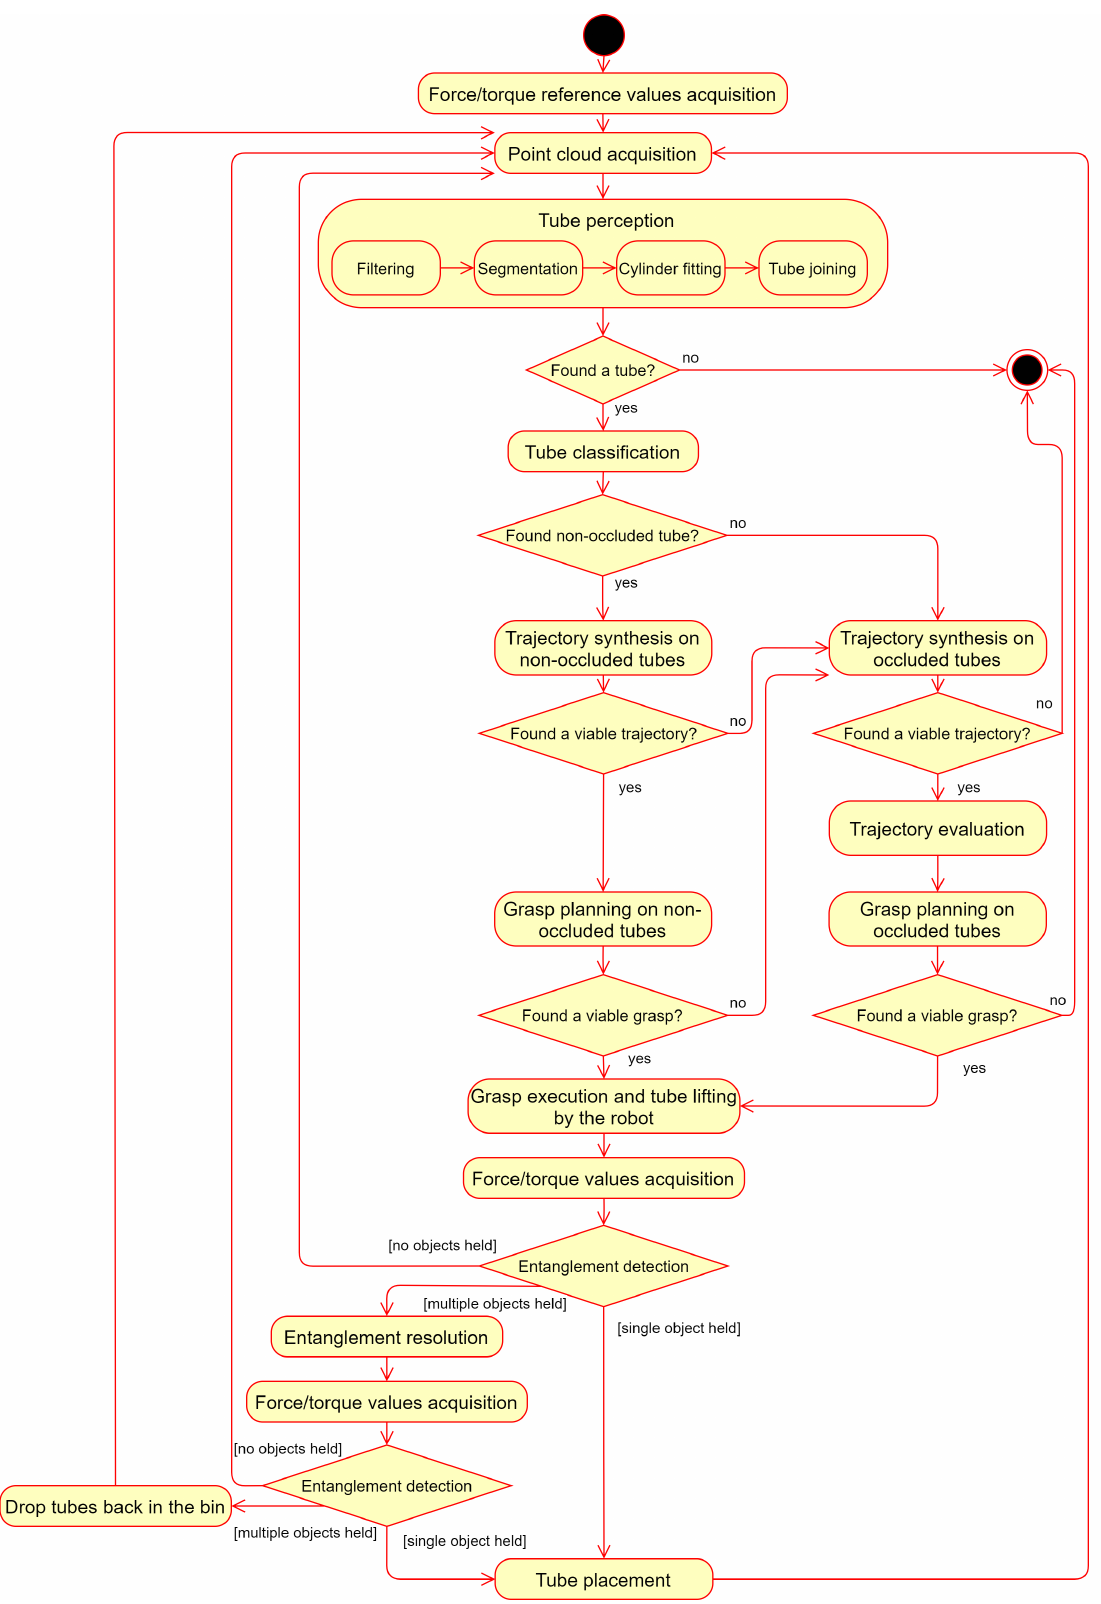
Figure 1. UML activity diagram of the bin picking